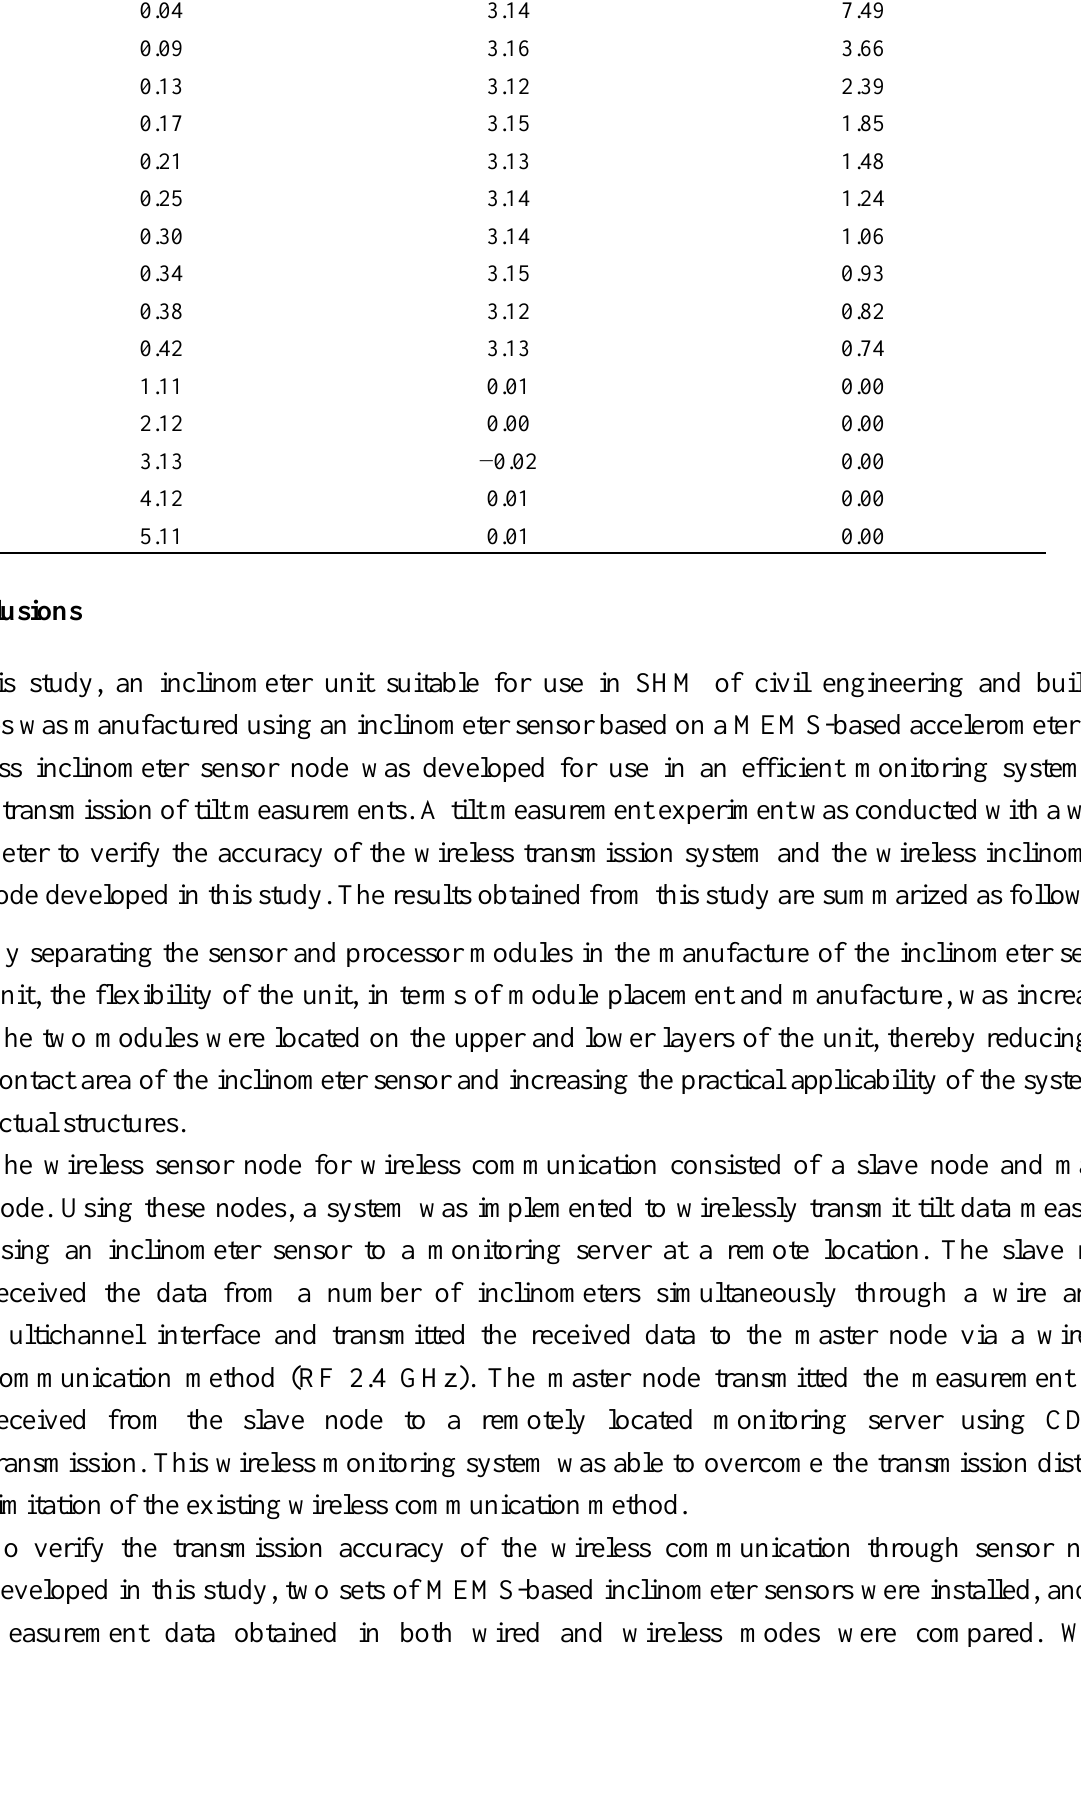
Table 1. Differences in inclinations measured by wired and wireless inclinometers. Tilt Values from LVDT